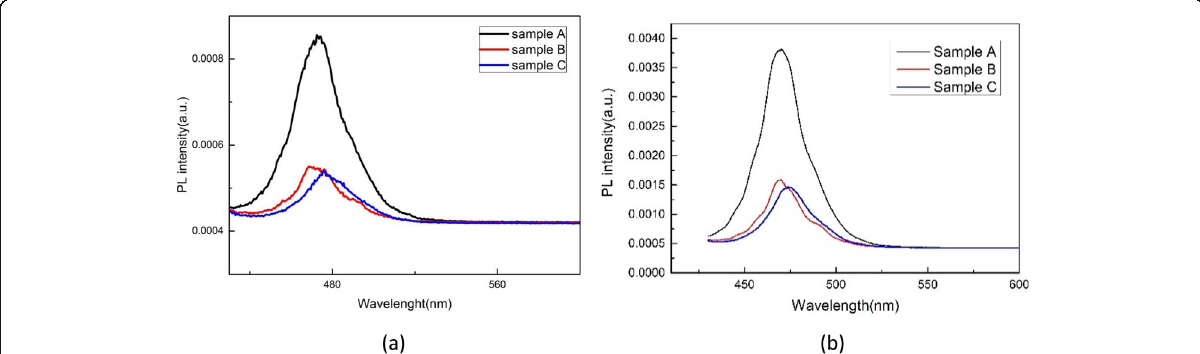
Fig. 4 Room-temperature PL spectra for samples A, B, and C by using a 405 nm GaN semiconductor laser ( a ) and 325 nm He-Cd laser ( b ). The peak wavelength is 473.1 nm, 472.9 nm, and 478.2 nm obtained from ( a ) and 470.5 nm, 470.1 nm, and 475.2 nm obtained from ( b ) for samples A, B, and C,